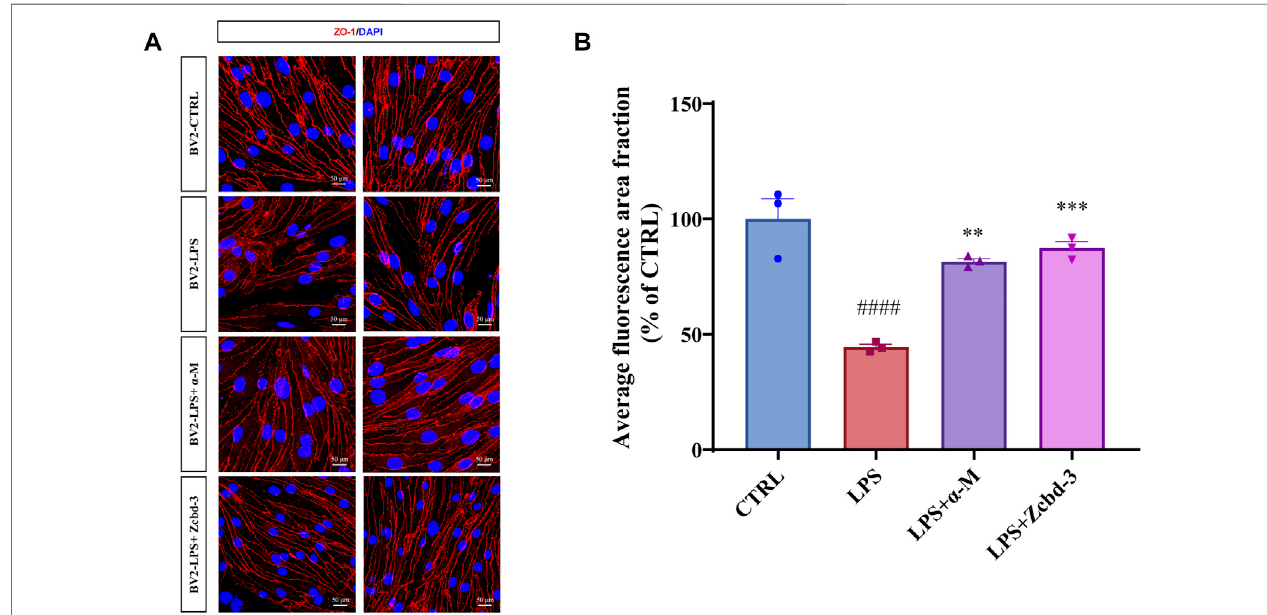
FIGURE6| α -MandZcbd- 3 ameliorated thealternationoftightjunction(TJ)proteinZonulaOccluden-1(ZO-1)inLPS-stimulatedbEnd.3cells (A) α -MandZcbd- 3 preserved the expression and location ofZO-1 localization inLPS-treated bEnd.3 cells. Mouse brainendothelialbEnd.3 cells were pre-treated with α -M or its analogues for2 hpriortostimulationwithLPS(100 ng/ml)foranother24 h.Thenthecellswere fi xedandstained.Themorphologyand fl uorescenceintensityofZO-1wasdetected by a confocal laser-scanning microscope (B) The bar graph showed the quantitation of the average fl uorescence area fraction in bEnd.3 cells. All data represent mean ±SEM from 3 independent experiments. ** p < 0.01, *** p < 0.001, **** p < 0.0001 compared to theLPS-stimulated group (LPS); #### p < 0.0001compared to the control group (CTRL). DAPI: blue, ZO-1: red, Scale bar: 50 μ M.